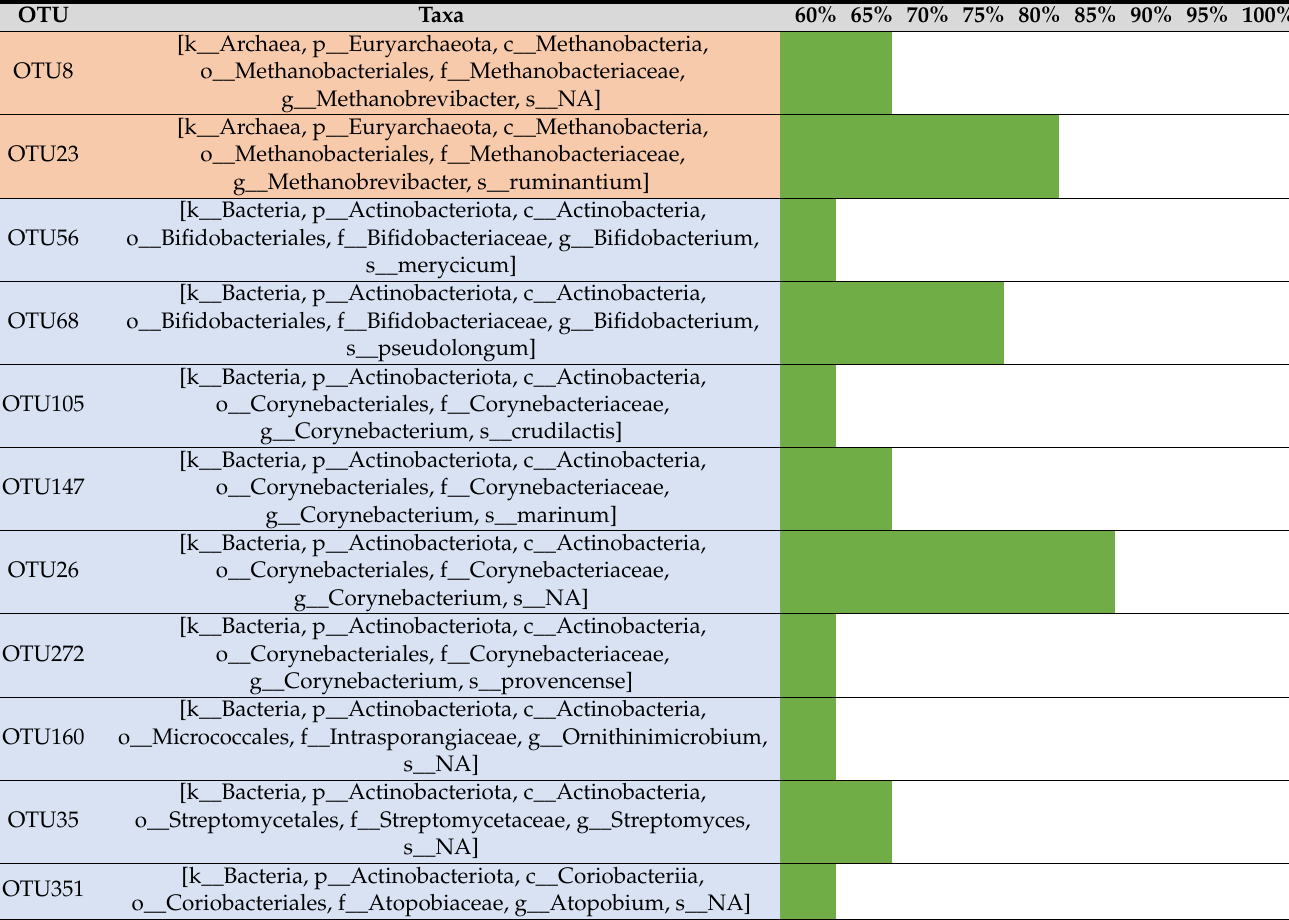
Table 4. OTUs identified in the nasopharyngeal, ruminal and vaginal microbiota of 60% of samples from yearling and pregnant heifers.